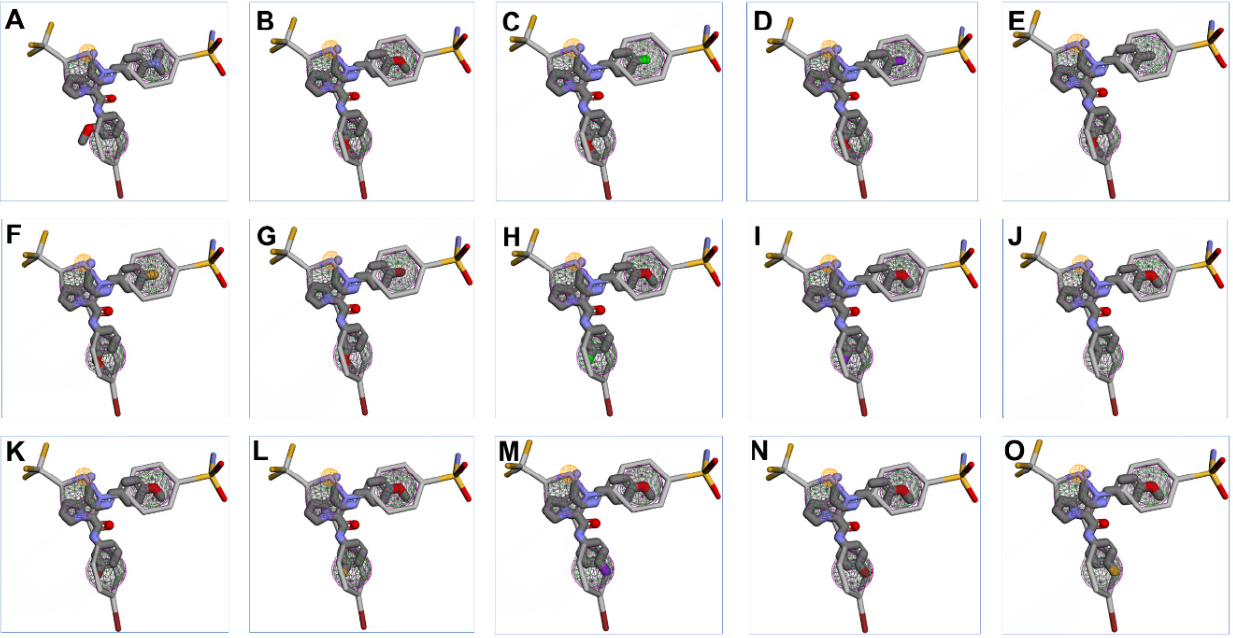
Figure 6. The top fifteen hits 1 – 15 (shown as sticks) overlaid with SC-558 (shown as sticks): ( A ) hit 1 ; ( B ) hit 2 ; ( C ) hit 3 ; ( D ) hit 4 ; ( E ) hit 5 ; ( F ) hit 6 ; ( G ) hit 7 ; ( H ) hit 8 ; ( I ) hit 9 ; ( J ) hit 10 ; ( K ) hit 11 ; ( L ) hit 12 ; ( M ) hit 13 ; ( N ) hit 14 ; ( O ) hit 15 .